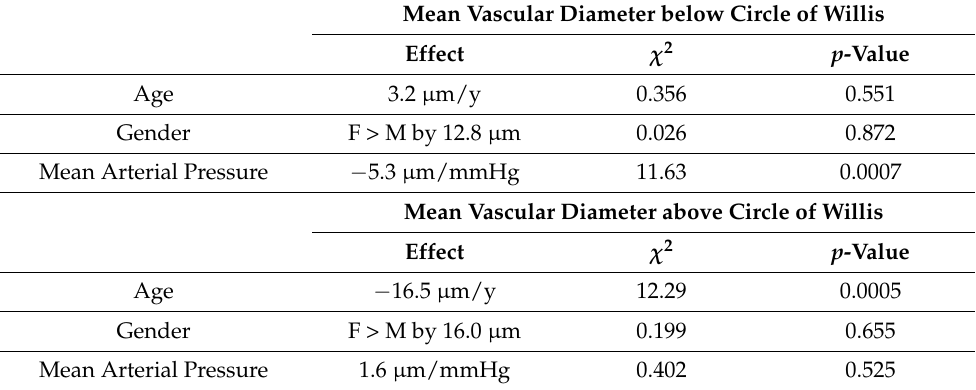
Table 2. Statistical evaluation mixed effects linear model, where p -values < 0.05 were considered statistically significant. Diameter denotes size of vasculature in segmentation images. Age, gender, and timepoints are clinically acquired data.